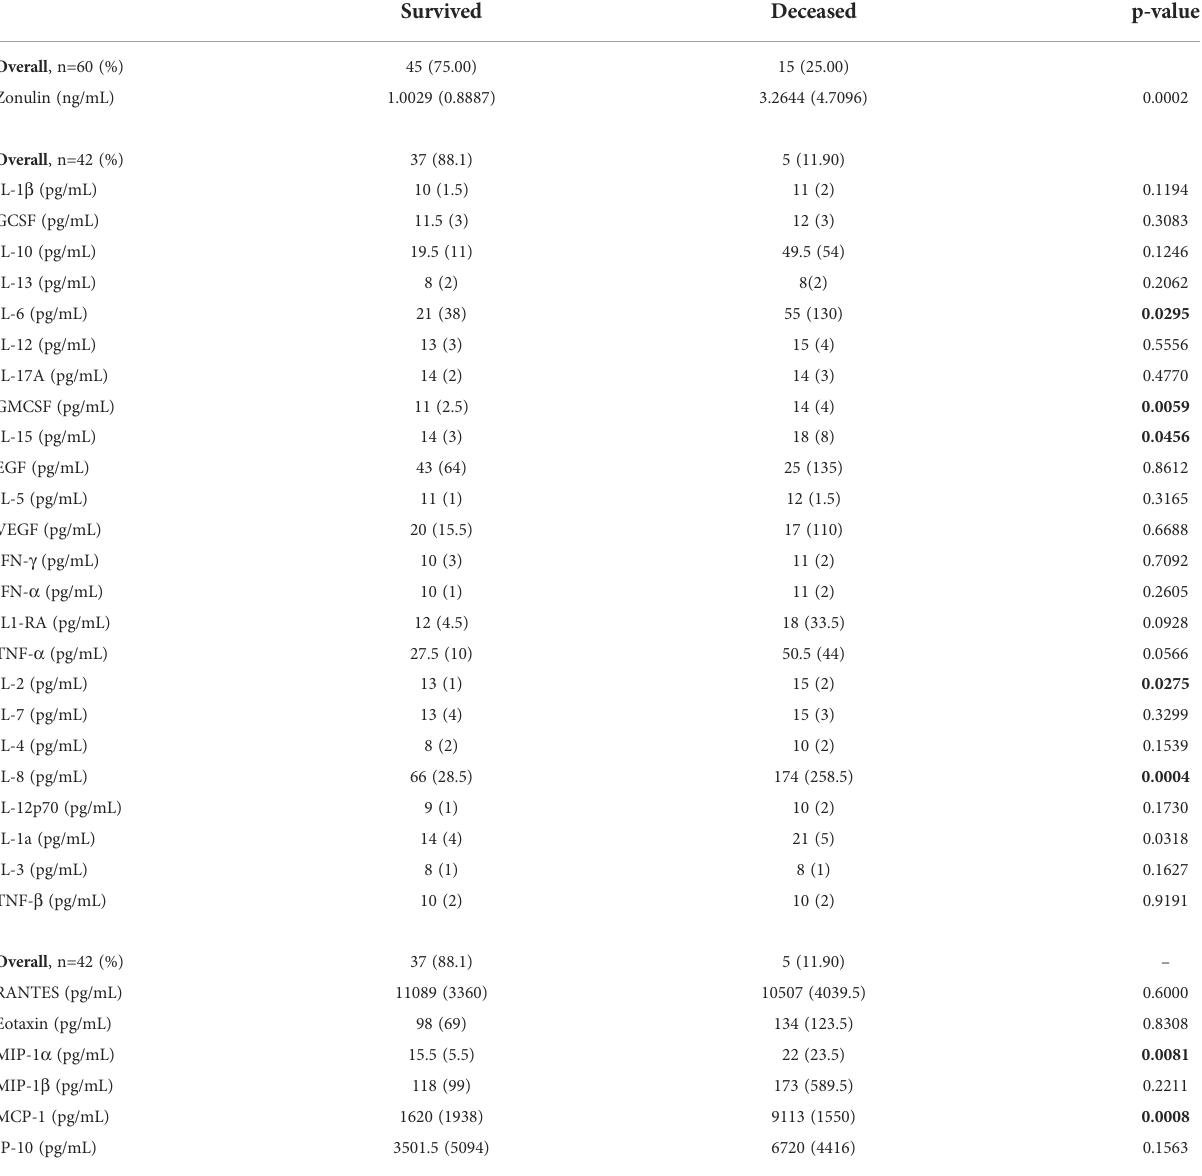
TABLE 2 Zonulin, cytokines and chemokines values in serum at baseline by